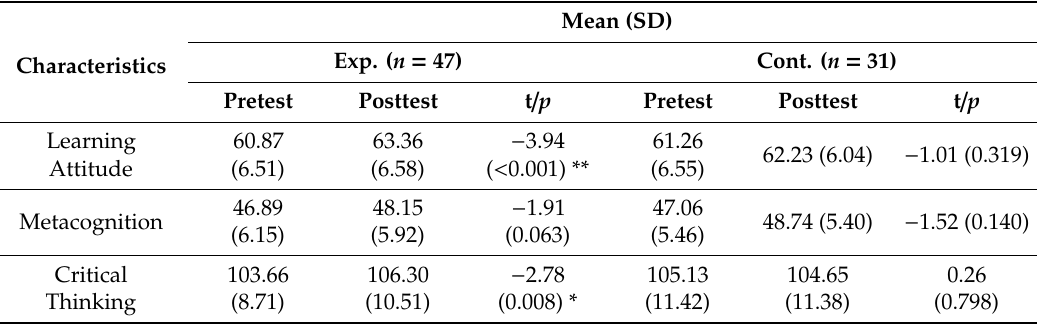
Table 3. E ff ects of